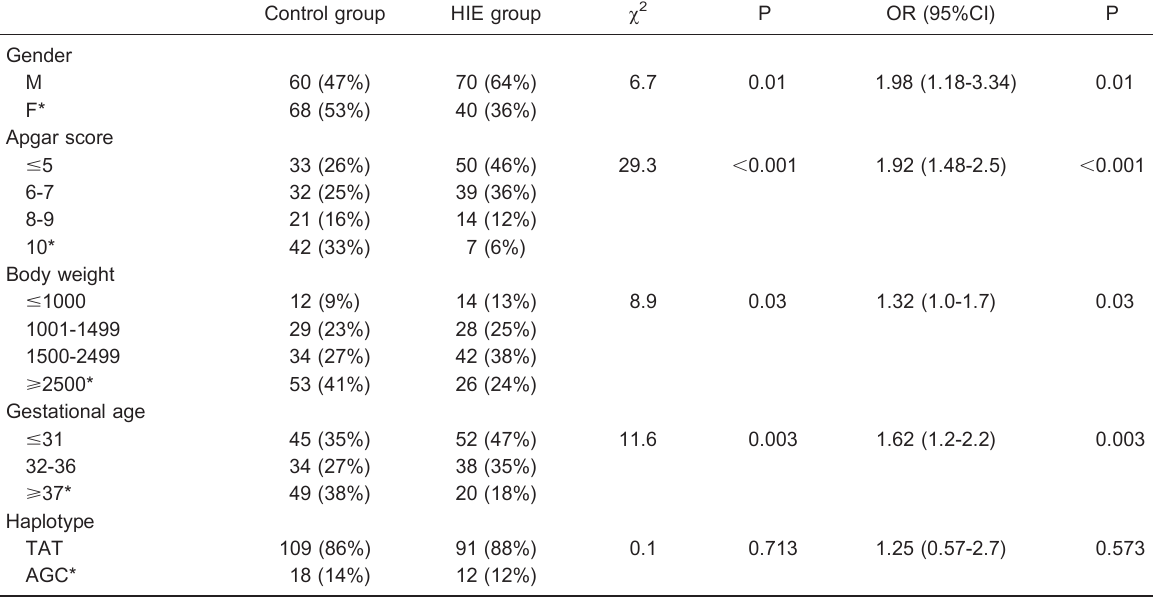
Table 4. Odds ratios for occurrence of hypoxic-ischemic encephalopathy according to gender, Apgar score, body weight, gestational age and haplotype distribution.